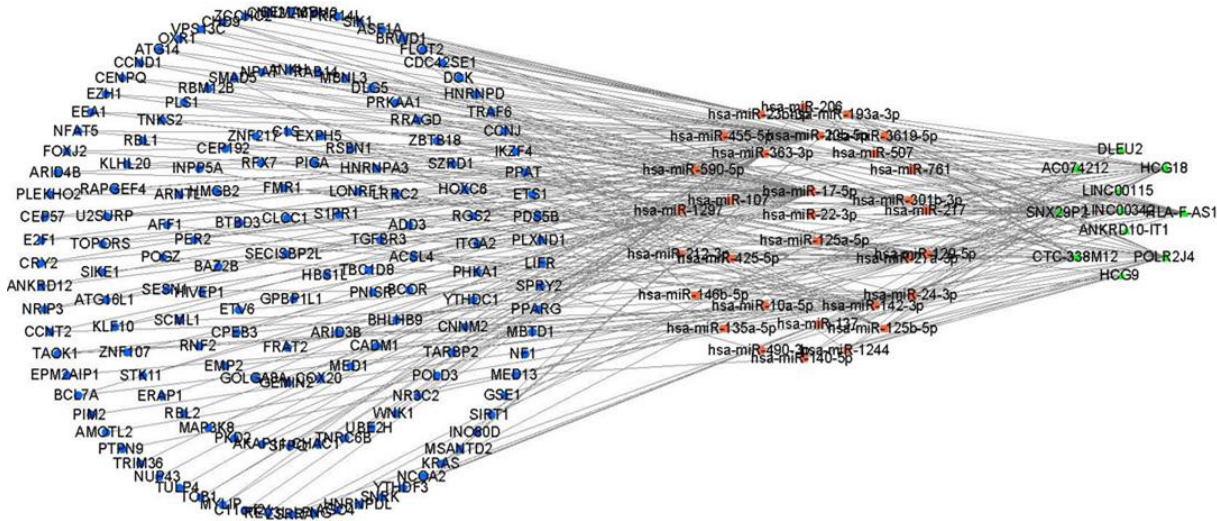
Figure 2. The construction of the ceRNA network including 11 DElncRNAs, 31 predicted miRNAs and 155 DEmRNAs. The circle in green, the rectangle in red and the triangle in blue represent DEmRNAs, miRNAs and DElncRNAs, respectively. DElncRNAs: differentially expressed lncRNAs; DEmRNAs: differentially expressed mRNAs; miRNAs: microRNAs.